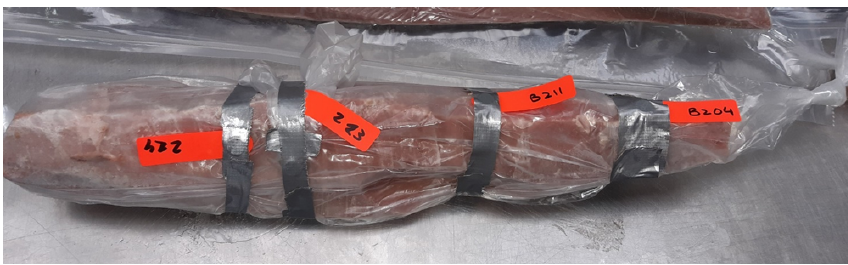
Figure 1. Frozen Mexican tuna loin with IButtons data loggers for temperature measurement.